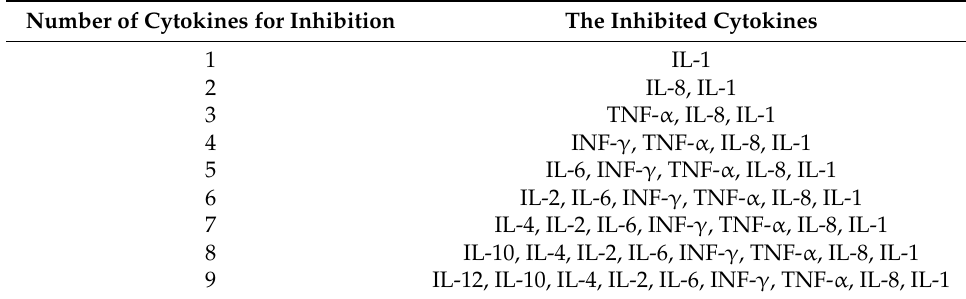
Figure 8. The CRS grades when various numbers of cytokines were inhibited. The cytokines that were inhibited to return the plotted CRS in this figure were listed in Table 1. Table 1. The cytokines that were inhibited to return the cytokine release syndrome (CRS) grade shown in Figure 8.